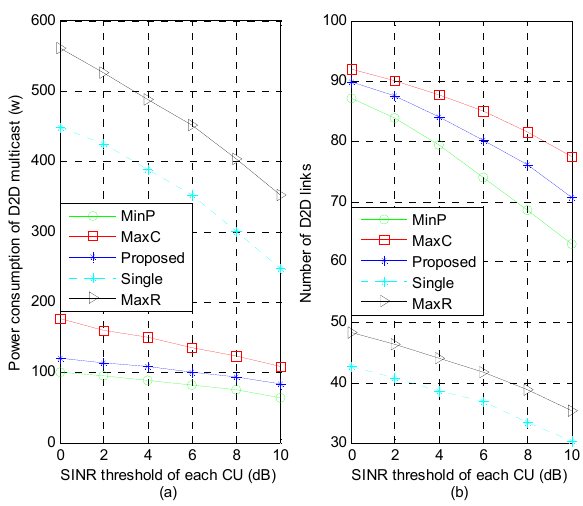
Figure 5. Power consumption and number of D2D links versus signal ‐ to ‐ interference ‐ plus ‐ noise ratio (SINR) threshold of each CU: ( a ) Impact of SINR requirement of CUs on power consumption; ( b ) Impact of SINR requirement of CUs on system capacity.